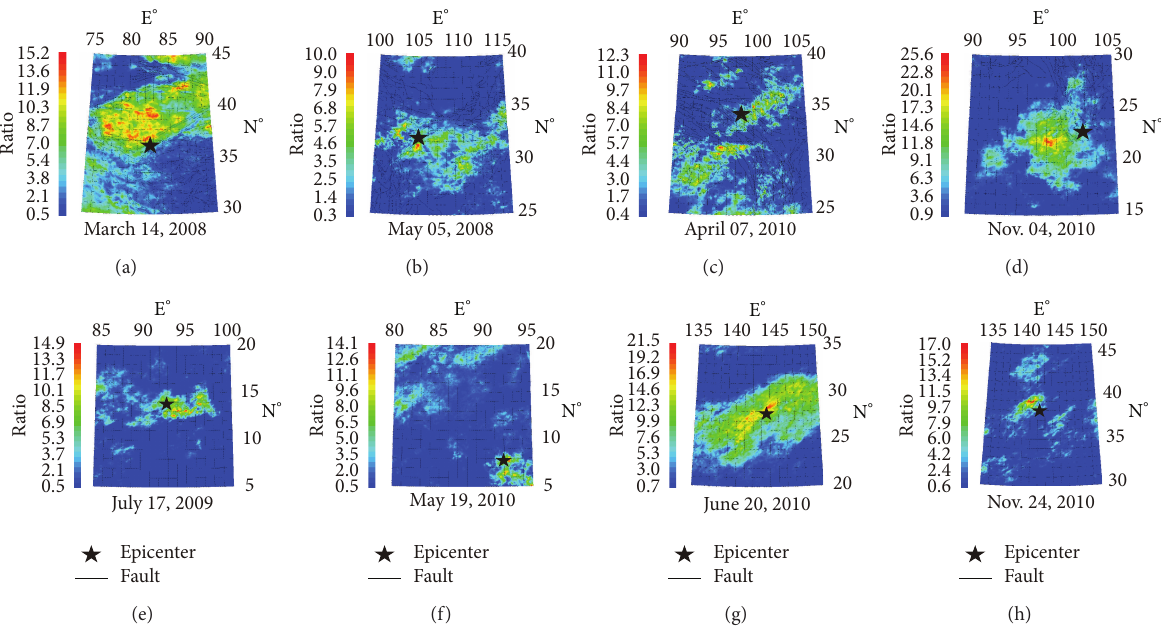
Figure 3: Information extraction result of earthquake thermal infrared anomalies ((a) Yutian Ms 7.3 earthquake; (b) Wenchuan Ms 8.0 earthquake; (c) Yushu Ms 7.1 earthquake; (d) Myanmar Ms 7.2 earthquake; (e) Andaman Islands Ms 7.5 earthquake; (f) Nicobar Islands Ms 7.6 earthquake; (g) Bonin Islands Ms 7.4 earthquake; (h) Northeast Honshu Ms 9.0